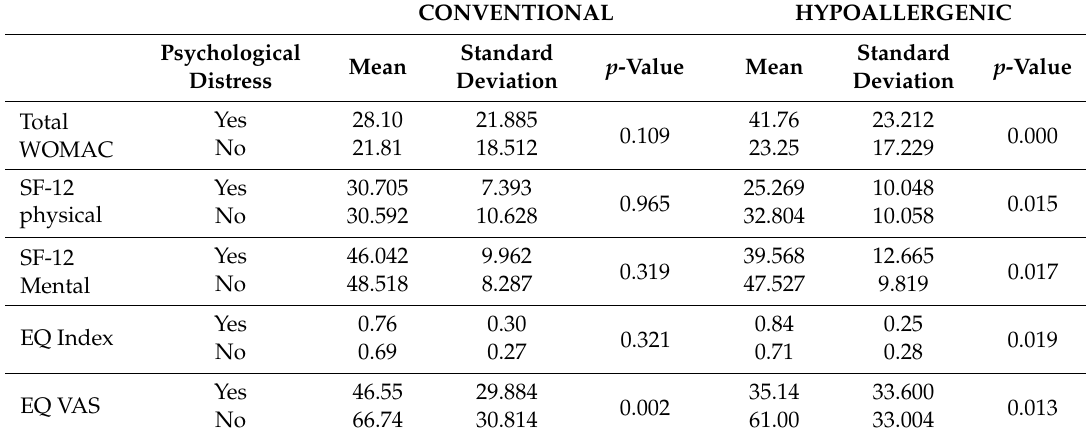
Table 9. Results of Student’s t for independent samples for psychological distress in patients treated with conventional and hypoallergenic implants with respect to the results of the questionnaires (WOMAC, SF-12, and